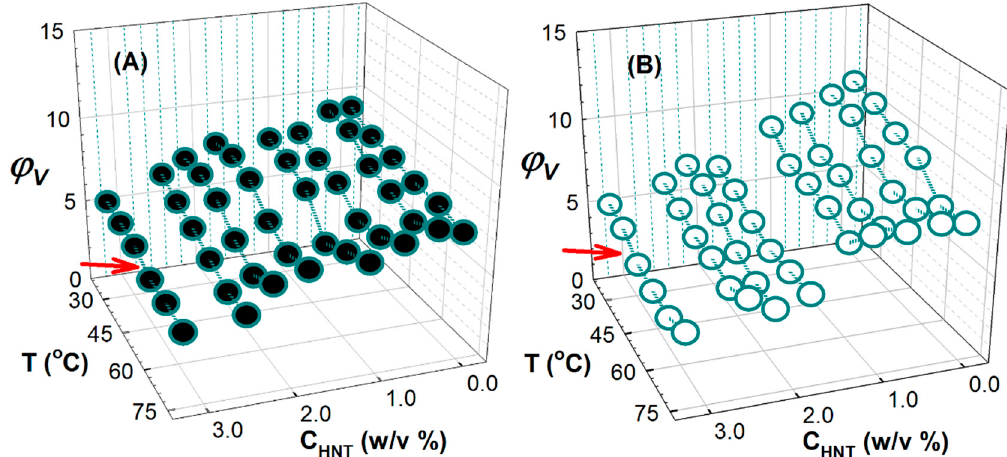
Figure 9. Temperature-dependent equilibrium volume swelling ratio ϕ V of ternary hybrid HNTm/PHAD-Hgs ( A ) and HNTm/PHAD-Cgs ( B ) as a function of HNT concentration and the swelling temperature (°C).